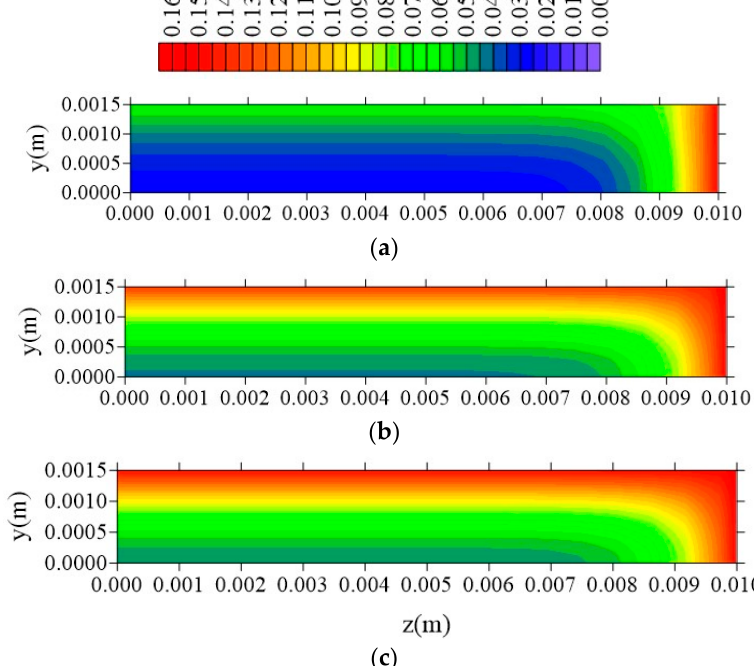
Figure 24. Distribution of free solute concentration (C in kg / kg) in plan x = R x / 2 for di ff erent distances l y (t = 211 h, Cases 9, 11, and 12). In which ( a ) l y = 0.001 m; l x = 0.1 m and l z = 0.1 m; ( b ) l y = 0.01 m; l x = 0.1 m and l z = 0.1 m; ( c ) l y = 0.1 m; l x = 0.1 m and l z = 0.1